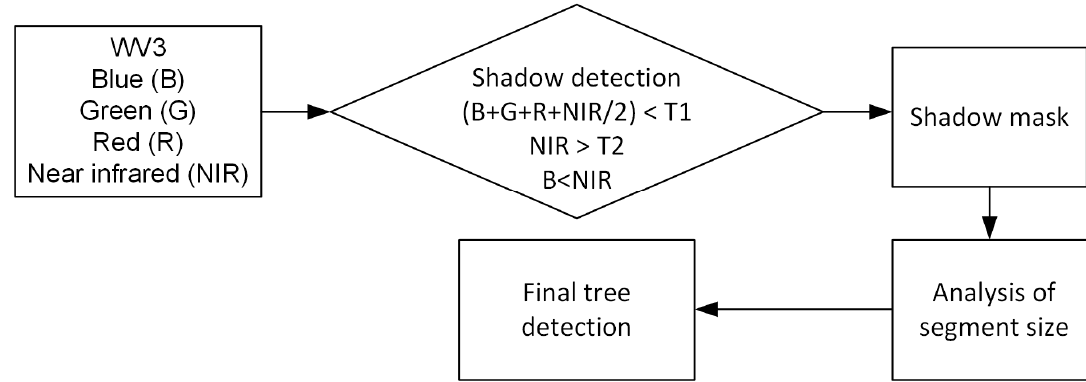
Figure 2. Coconut tree counting algorithm flowchart. Both thresholds T1 and T2 are equal to 50 digital numbers (DN).